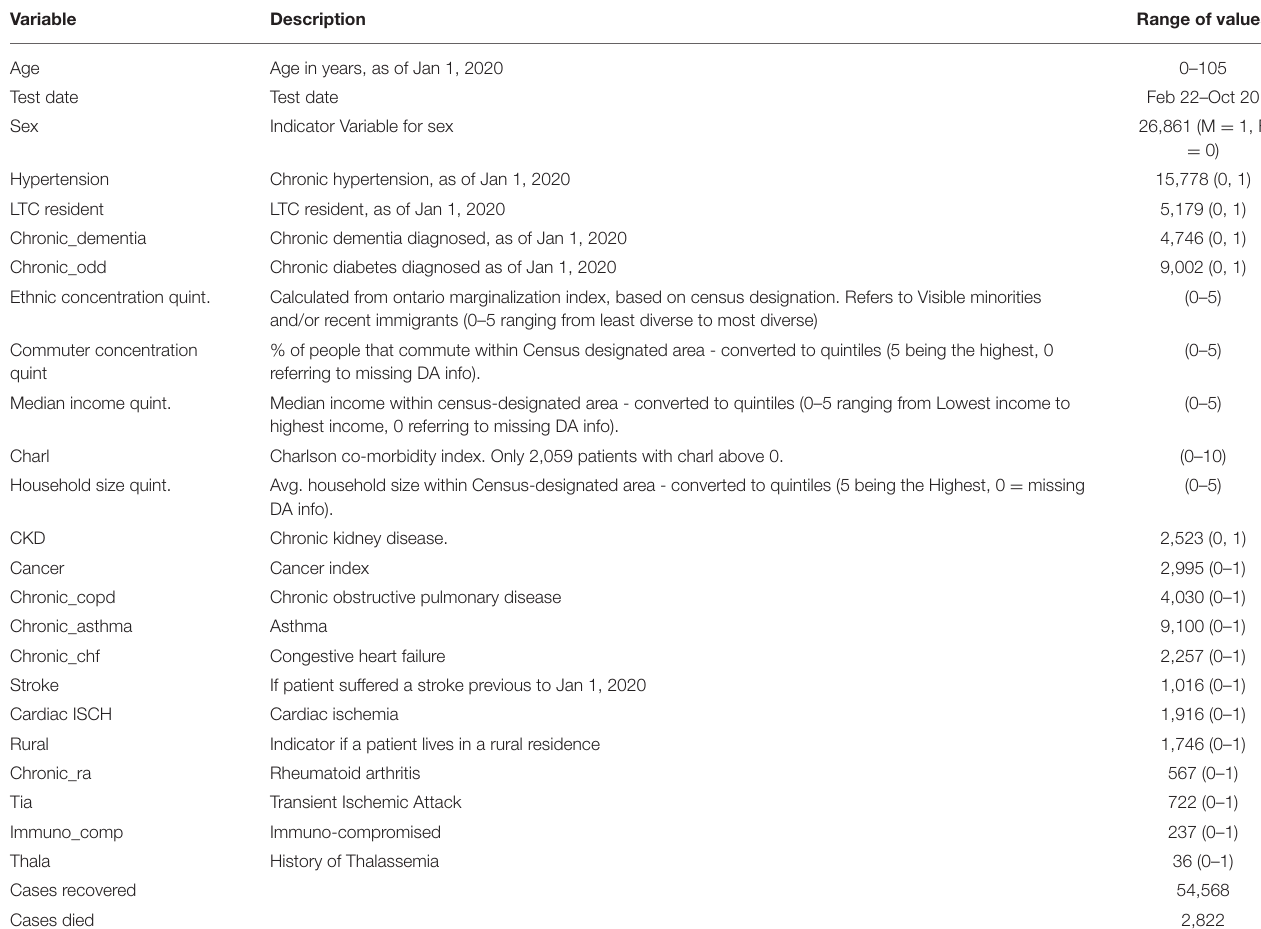
TABLE 1 | Characteristics of 57,390 Ontario residents with